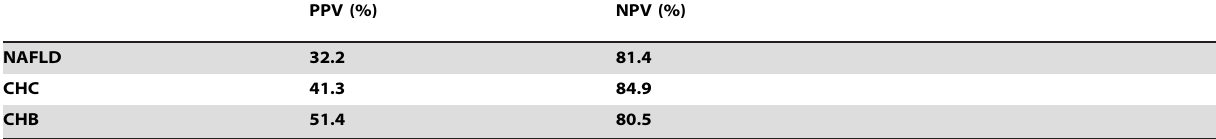
AUC of variables for severe liver fibrosis